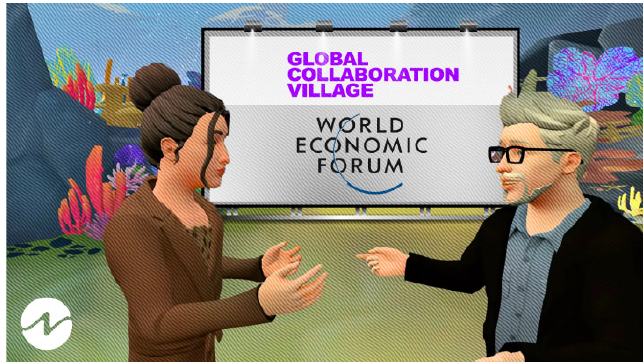
Figure 37: World Economic Forum in the Metaverse Enhanced Job